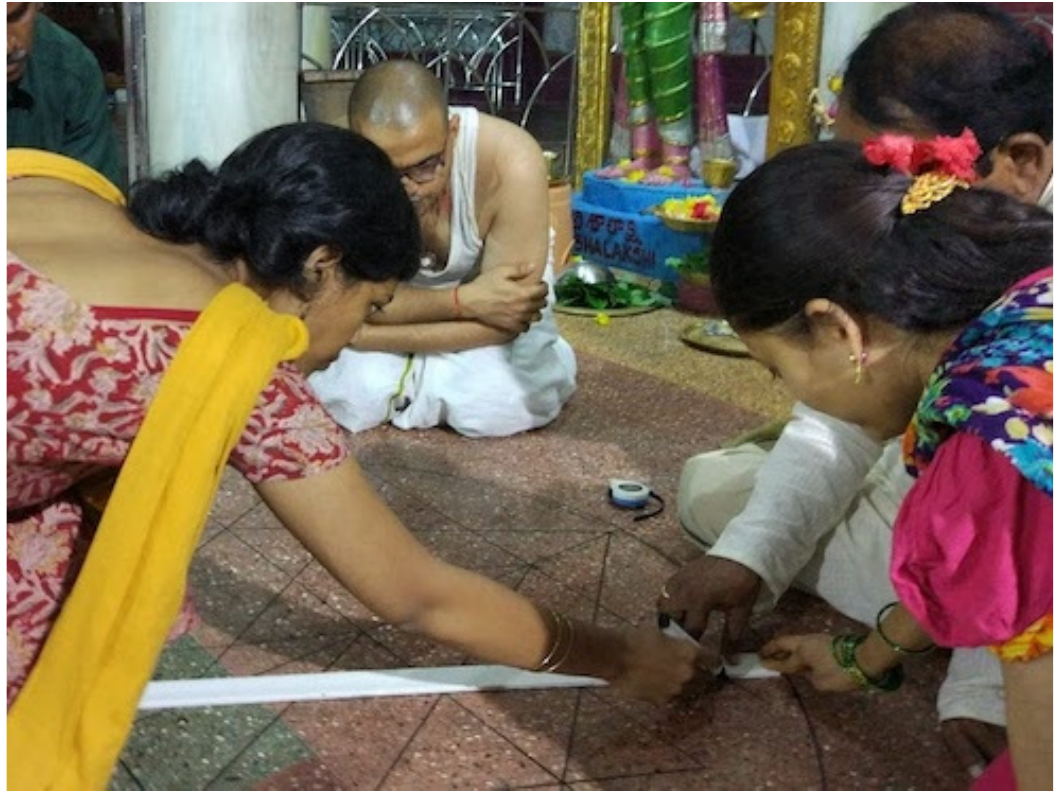
Figure 11. Drawing the Ś r ī cakra. Credit: author.